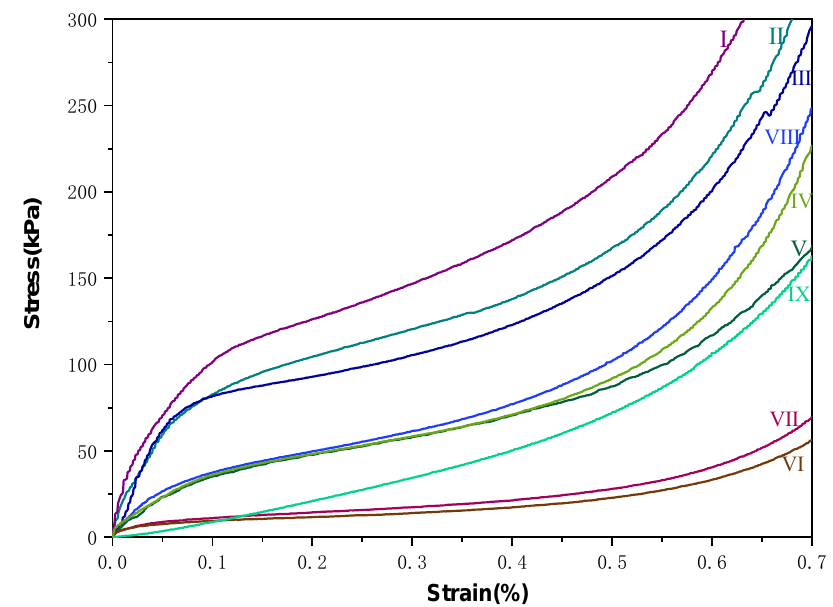
Figure 11. Stress and strain curves of materials with different water contents.